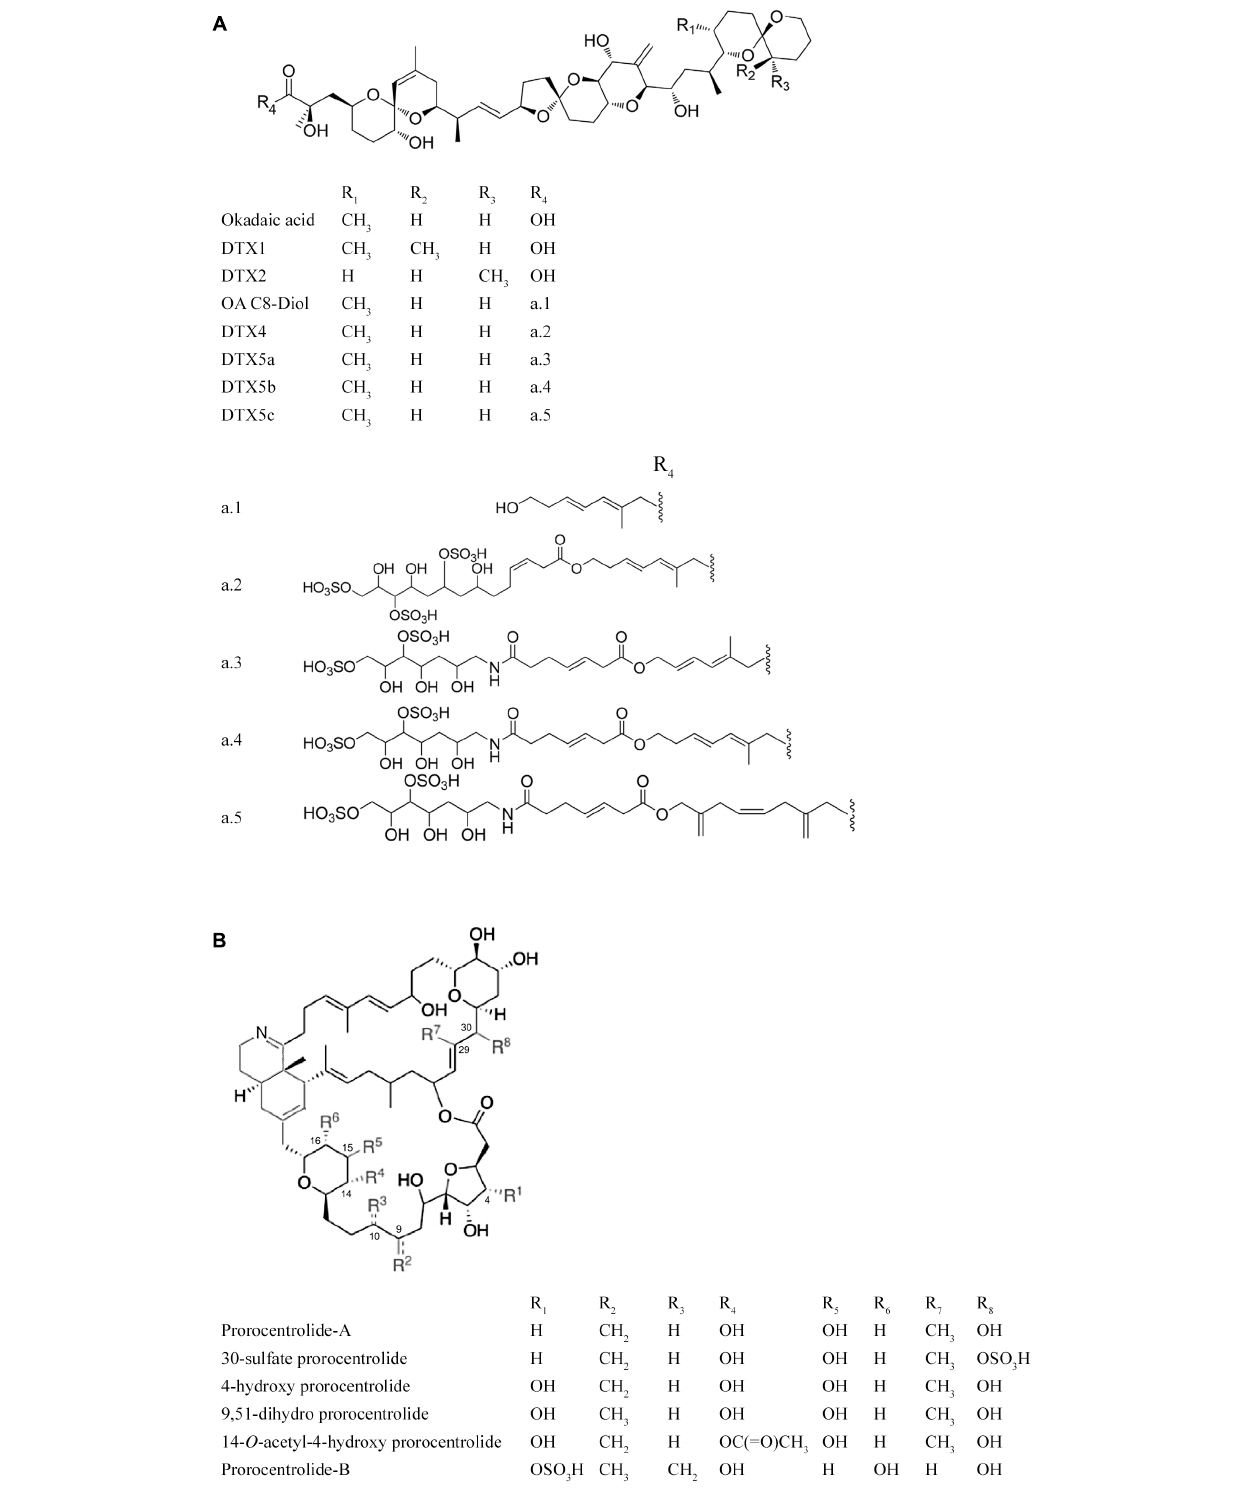
Frontiers in Marine Science |